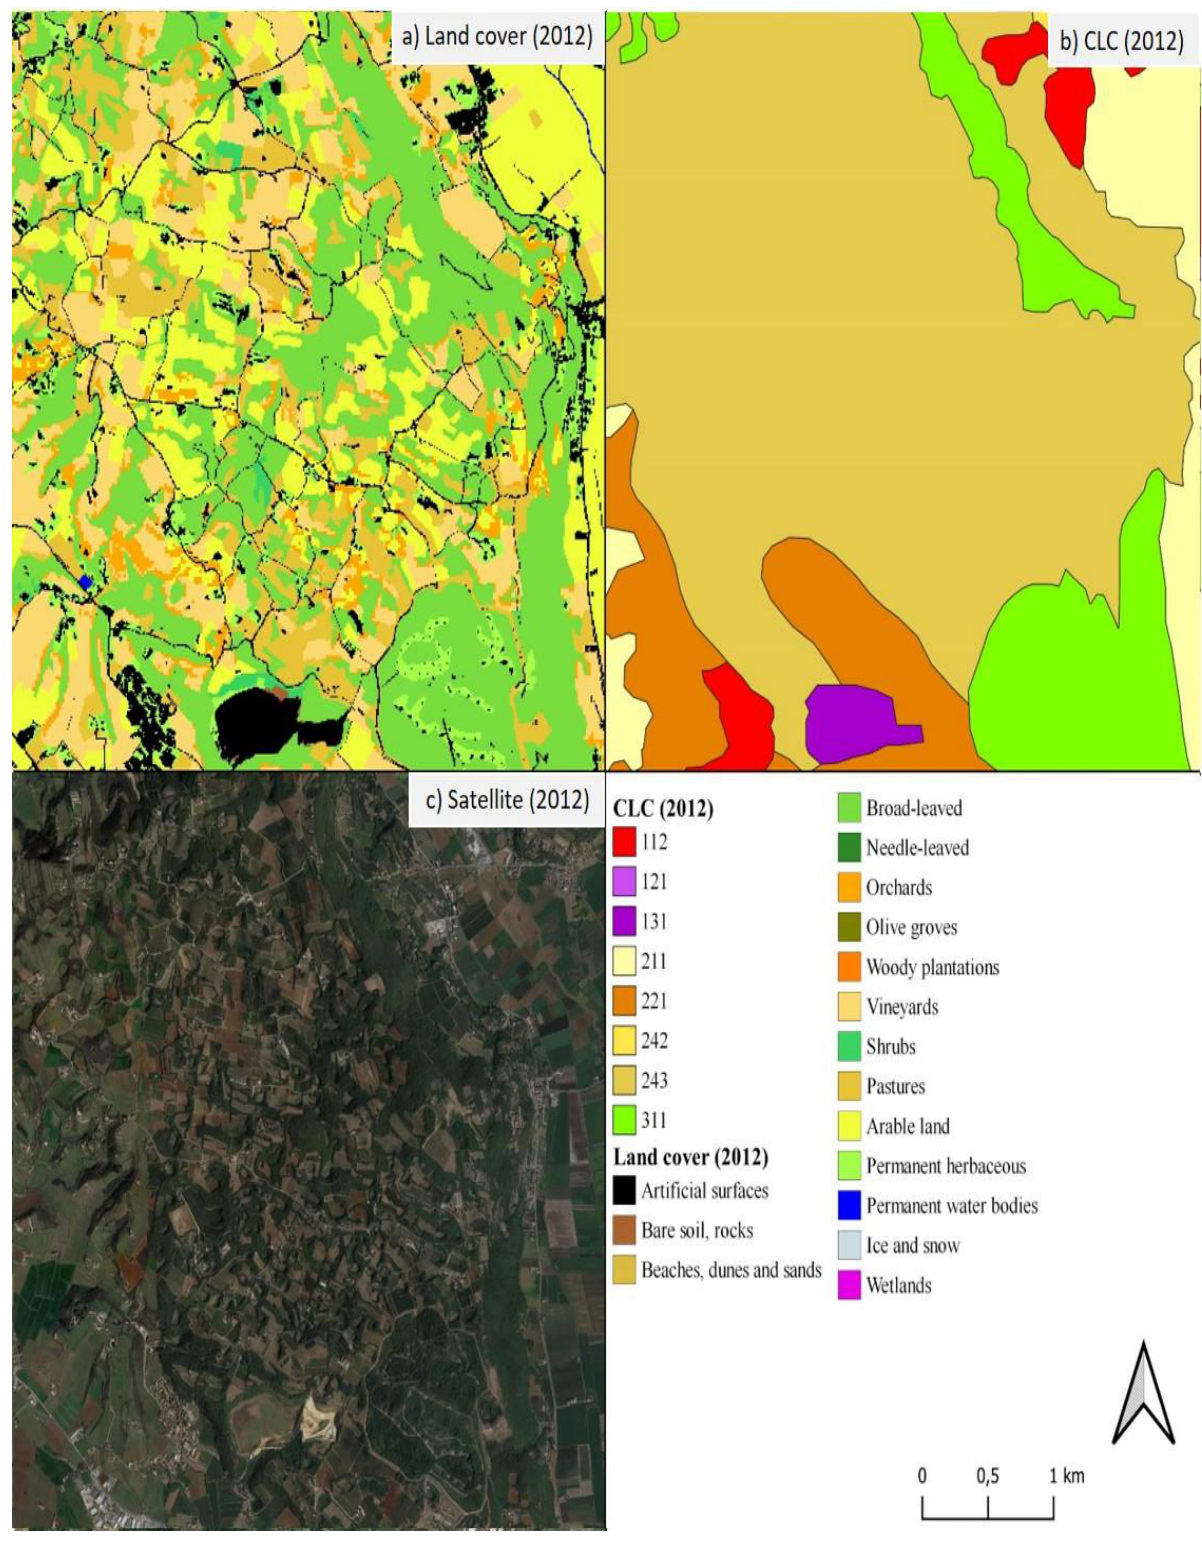
Figure 9. Comparison between land cover map for 2012 ( a ), CORINE Land Cover ( b ) and satellite image ( c ), focusing on heterogeneous agricultural areas.